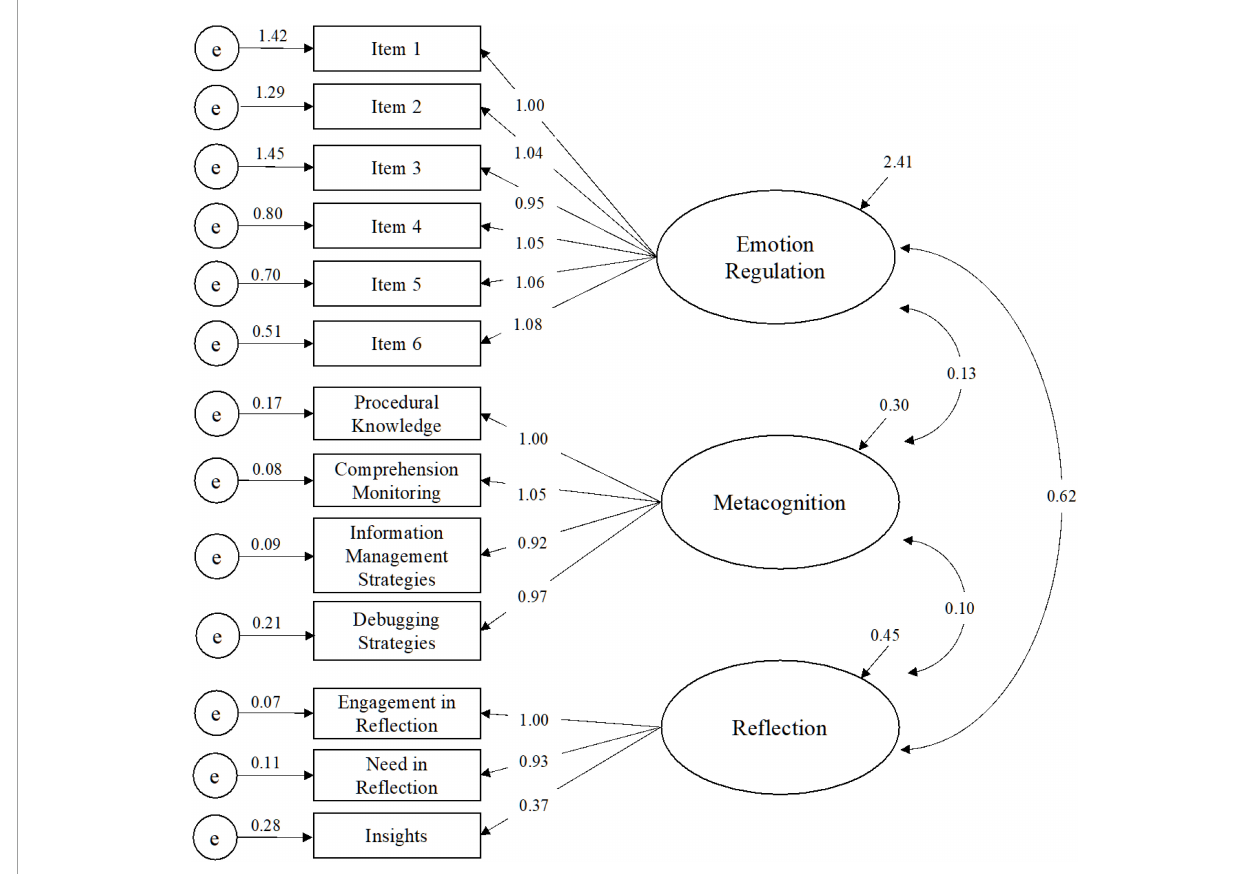
FIGURE1 Measurement model of the key constructs. Unstandardized coefficients are